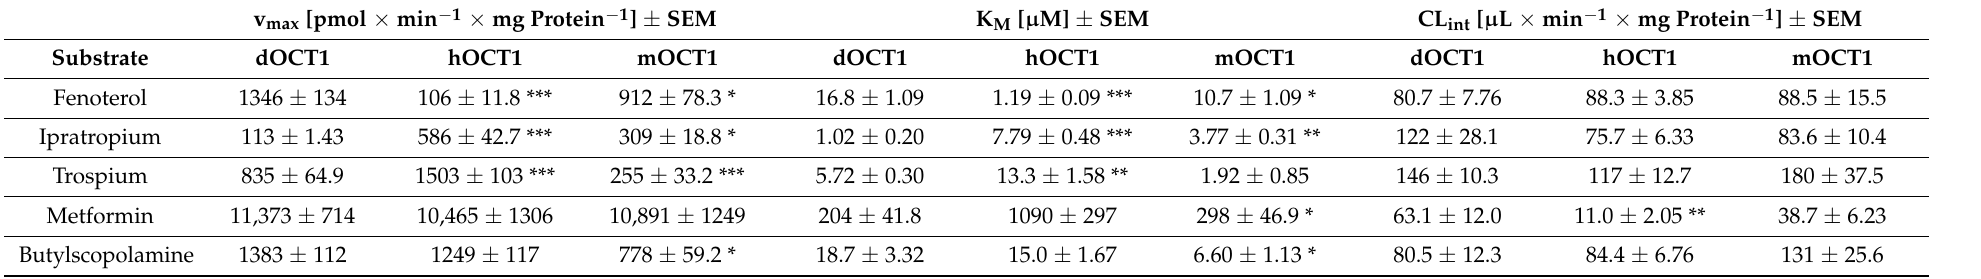
Table 1. Kinetic parameters of OCT1-mediated substrate uptake by dog, human, and mouse